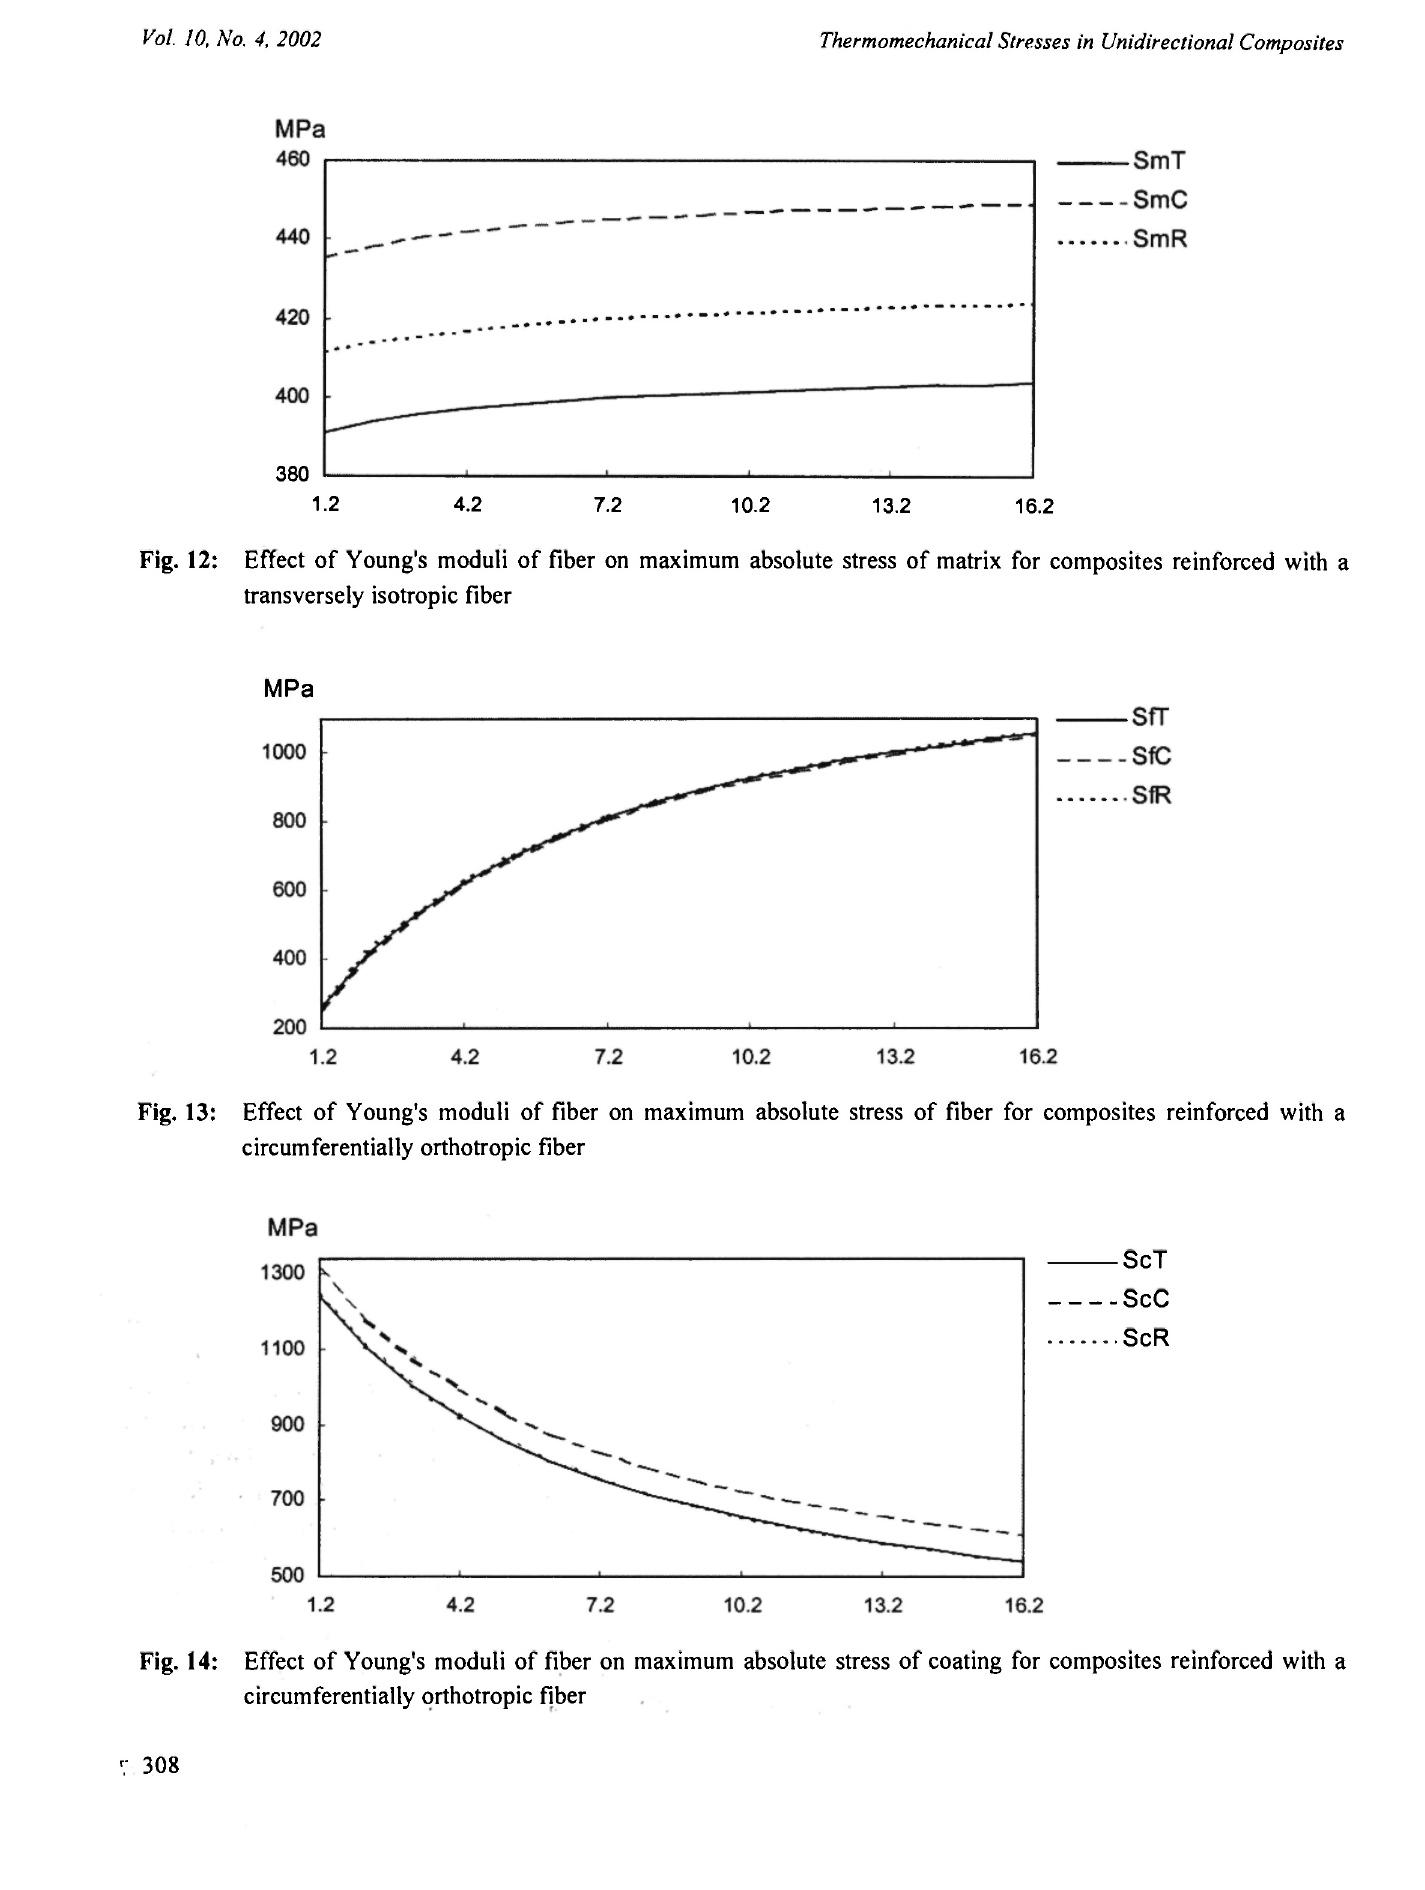
Fig. 12: Effect of Young's moduli of fiber on maximum absolute stress of matrix for composites reinforced with a transversely isotropic fiber